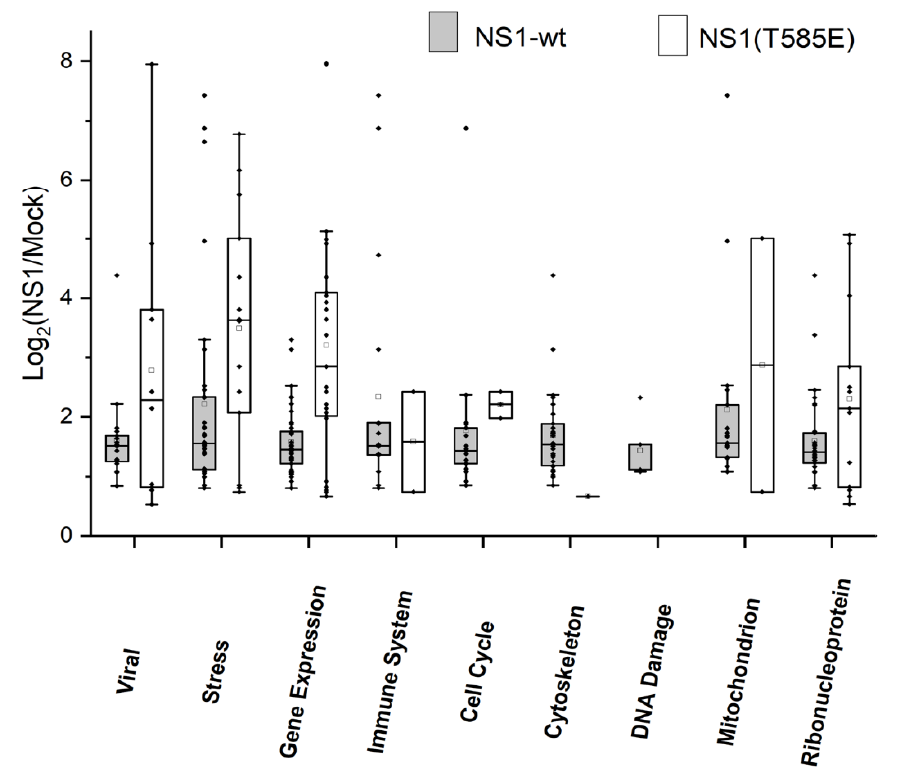
Figure 4. Identification of binding partners of NS1-wt and NS1-T585E by proteomics. Hep3B-cells were transfected with pTag-NS1-wt-GFP, pTag-NS1-T585E-GFP, or pTag-GFP-N. NS1-GFP fusion proteins were pulled down and cellular proteins binding to NS1 were identified by mass spectrometry. Proteins with a significantly higher abundance in NS1-wt-GFP or NS1-T585E-GFP compared to GFP-only pulldown, respectively, are grouped with respect to the indicated biological processes or cellular components. Box plot representation of median, 1st and 3rd quartile, whiskers as quartiles plus 1.5 times the interquartile range (IRQ), and outliers.